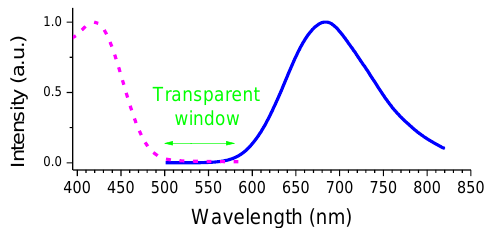
Figure 5. UV–vis absorption (dotted line) and fluorescence spectra (solid line) of fluorescent dye 1 (in CH 2 Cl 2 ) with a large Stokes shift. The dye 1 exhibits “a transparent optical window” between 500 and 580 nm.